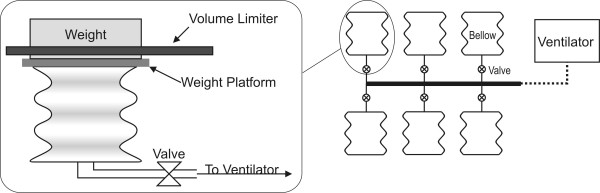
Schematic drawing of model. The lung is represented by 6 bellows connected to a ventilator. A platform is placed on top of rubber bellow to support weights, used to vary the driving pressure of the bellow. A volume limiter sets the maximum height of the platform, thus limits the height which the bellow is allowed to expand vertically. Each bellow is connected to the larger common tube through an adjustable valve.